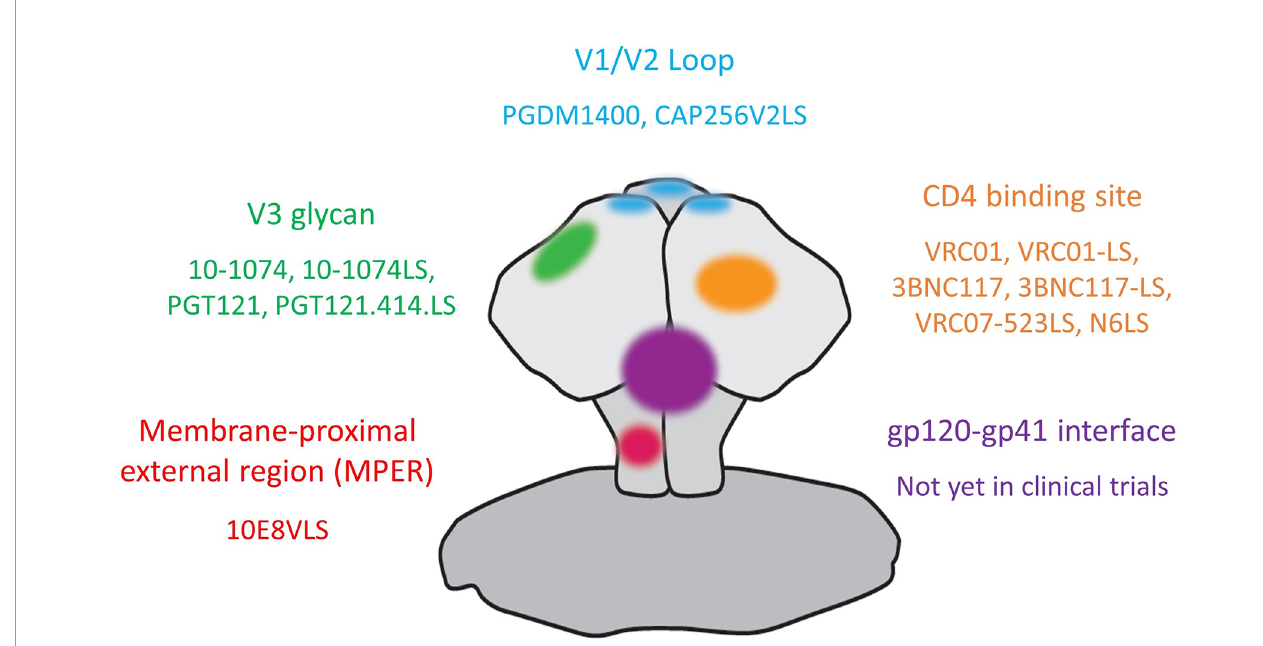
FIGURE 1 | Anti-HIV-1 broadly neutralizing antibodies in clinical trials and their targets on the HIV-1